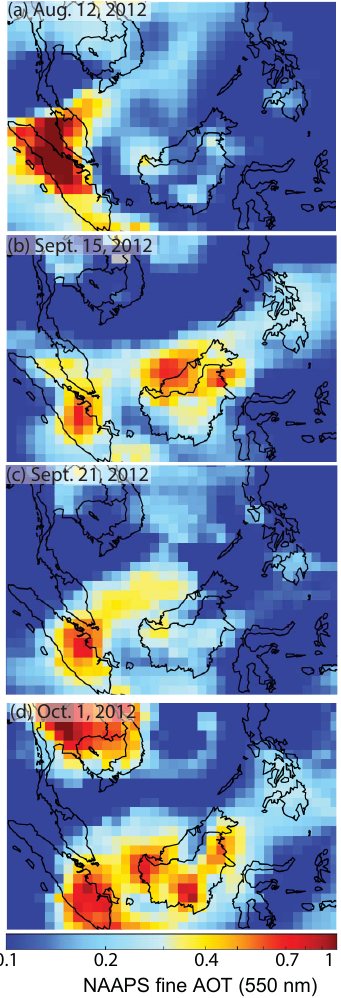
Figure 7. NAAPS fine-mode 550nm AOTs for midday ( ∼ 6Z) for four significant smoke transport